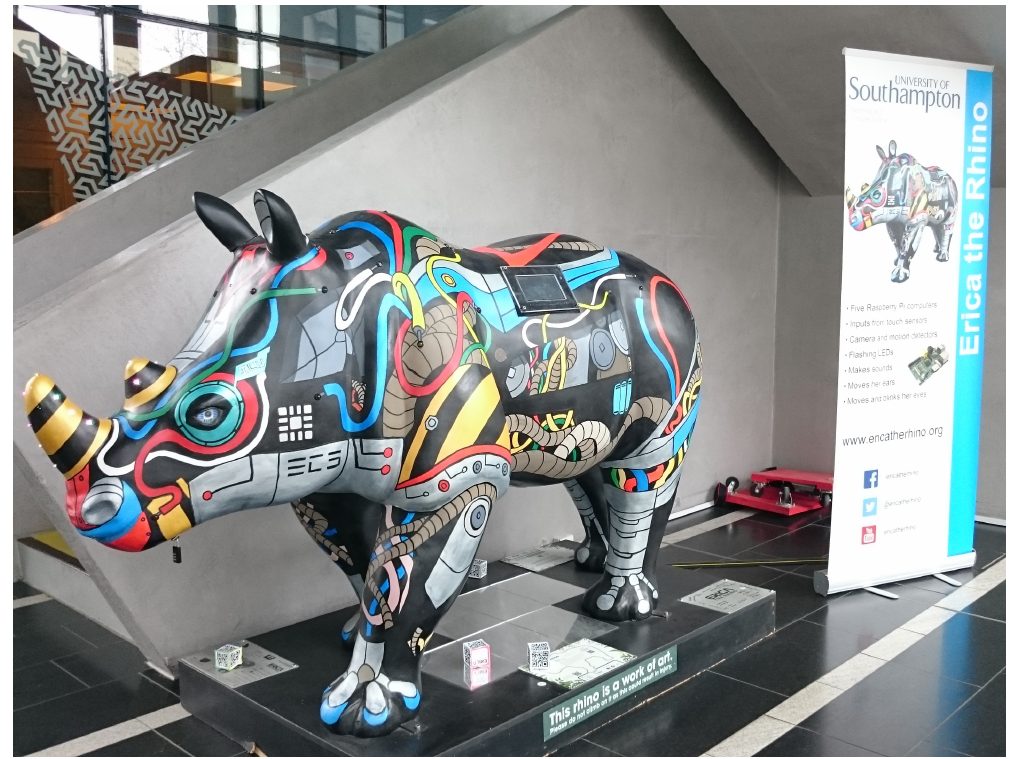
Figure 1. Erica the Rhino in her permanent home at the University of